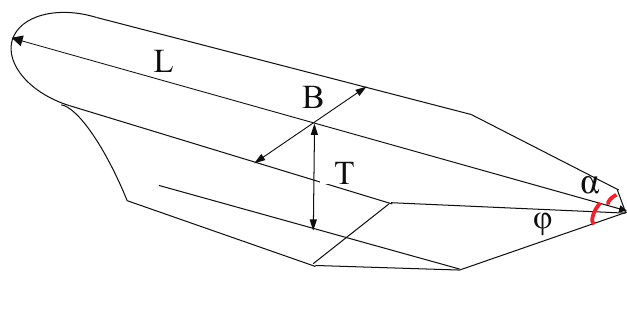
Figure 2. Approximation of hull form.